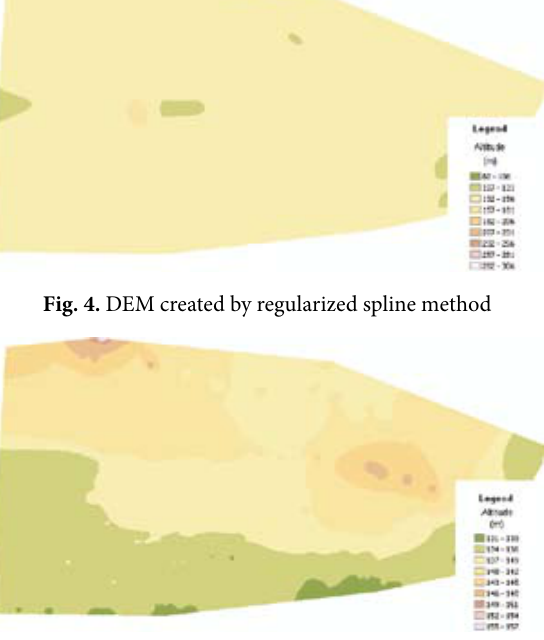
Fig. 5. DEM created by IDW method